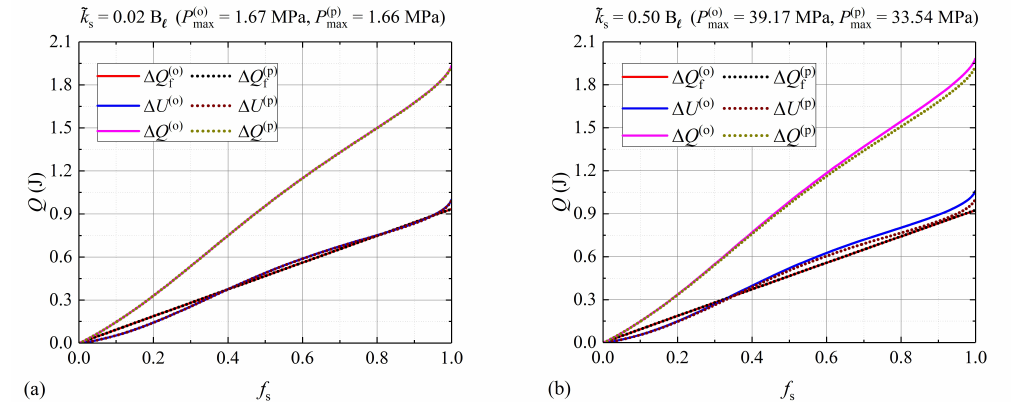
Figure 5. Absorbed energy for: ( a ) ˜ k s = 0.02 B (cid:96) and ( b ) ˜ k s = 0.5 B (cid:96) . Sensible heat ( ∆ U ), latent heat ( ∆ Q f ), and total energy ( ∆ Q ) absorbed by the nitrate salt during a melting process are shown for each value of ˜ k s . Continuous and dotted lines correspond to the FDM solutions obtained from the model introduced in [18] and the proposed model,